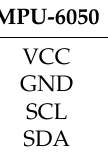
Table 3. Connection between the Bluetooth and Teensy 2.0 modules.